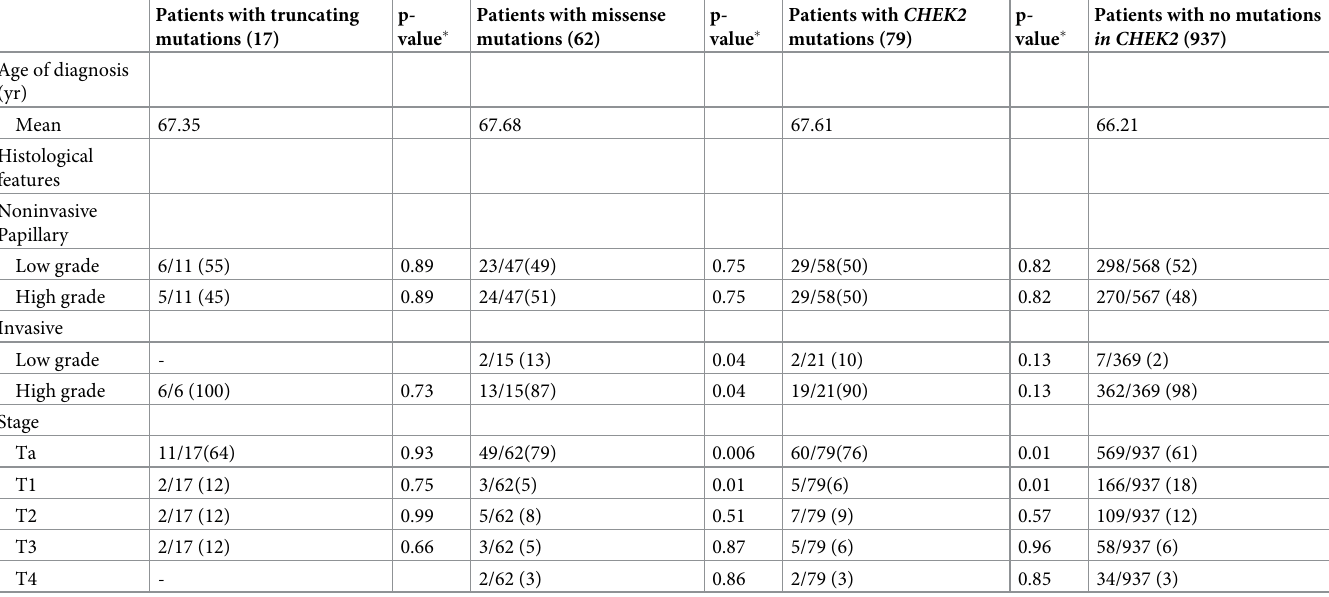
Table 2. Clinical characteristics of bladder cancers; by variant alleles of CHEK2 . Patients with truncating mutations (17)